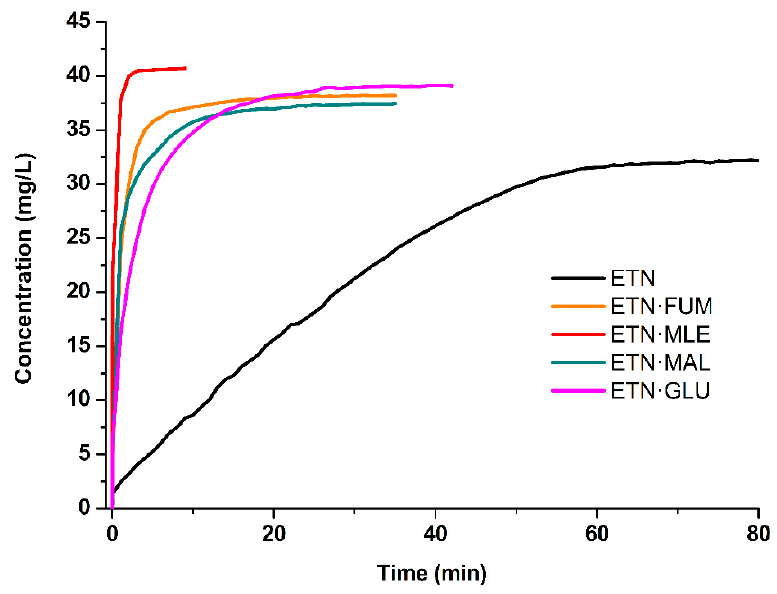
Figure 10. Dissolution profiles of pure ETN and all obtained adducts. Table 5. Normalized Area Under the Curve (AUC) values obtained by the dissolution curves of the obtained ETN adducts.